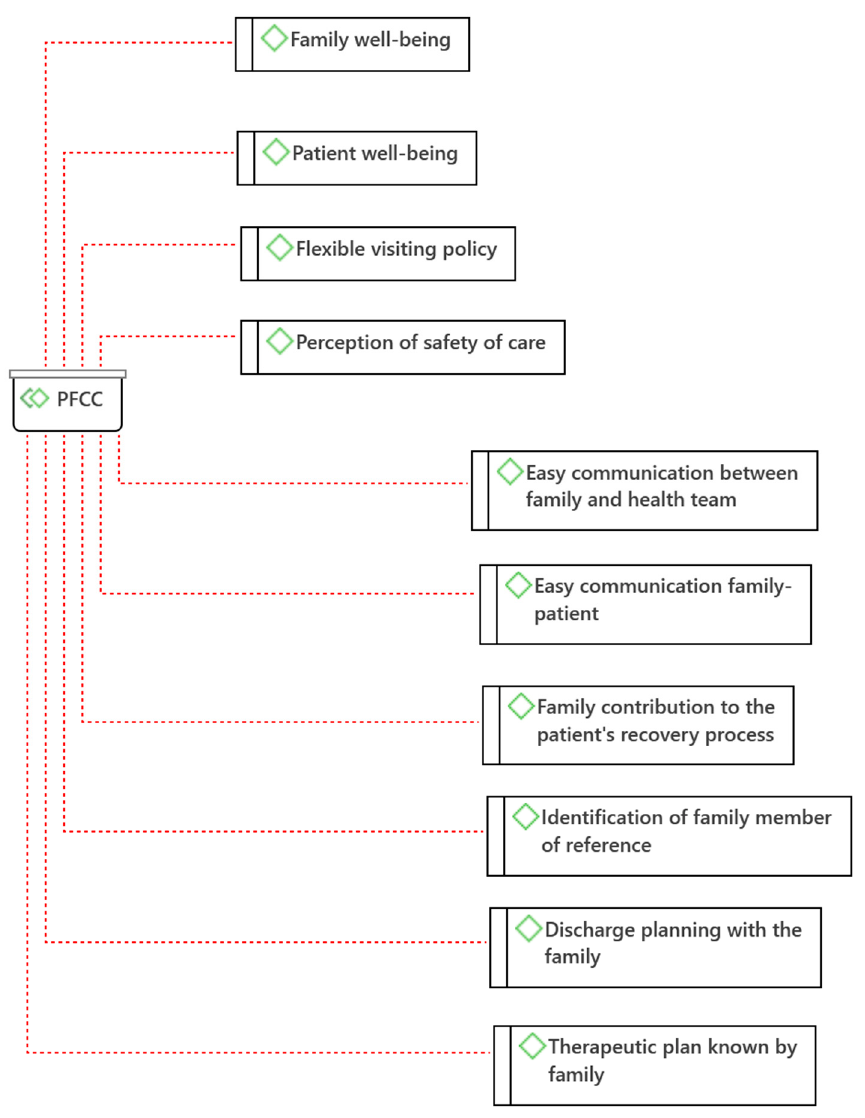
Figure 2. Person- and Family-Centered Care (PFCC) Categories (Atlas.ti ® ).